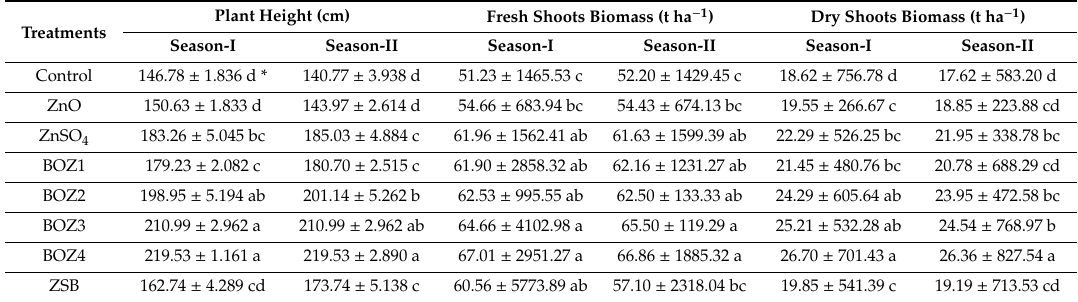
Table 2. E ff ects of di ff erent Zn sources on growth of maize grown in two di ff erent cropping seasons.